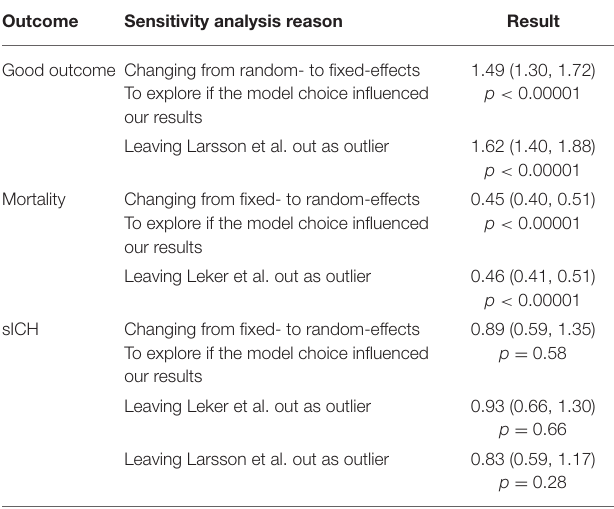
TABLE 3 | Results of the sensitivity analysis. Outcome Sensitivity analysis